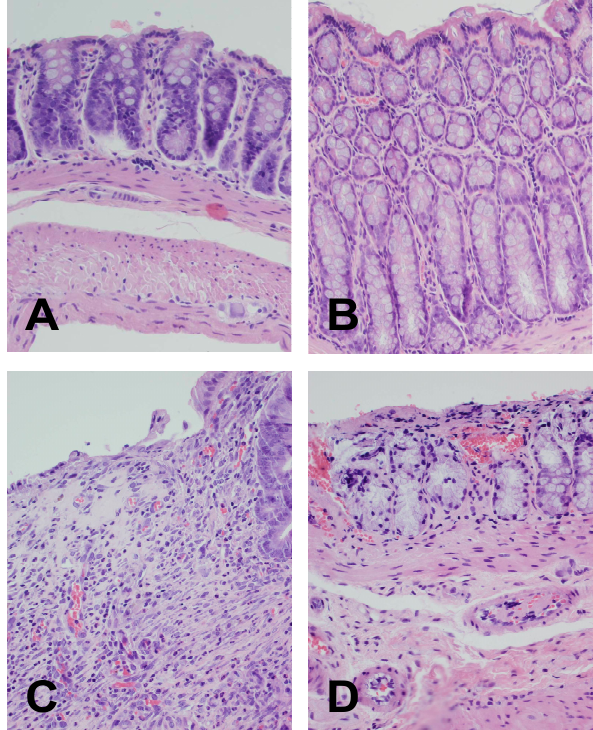
Figure 2. ( A ) Representative microscopic image of colonic mucosa observed in control rats without colitis; ( B ) Representative microscopic image of colonic mucosa observed 14 days after intraperitoneal (i.p.) treatment with obestatin at a dose of 8 nmol/kg without induction of colitis; ( C ) Representative microscopic image of colonic mucosa observed 14 days after induction of colitis evoked by TNBS; ( D ) Representative microscopic image of colonic mucosa observed 14 days after induction of colitis and i.p. treatment with obestatin at a dose of 8 nmol/kg. Hematoxylin and eosin stain. Original magnification 400×.